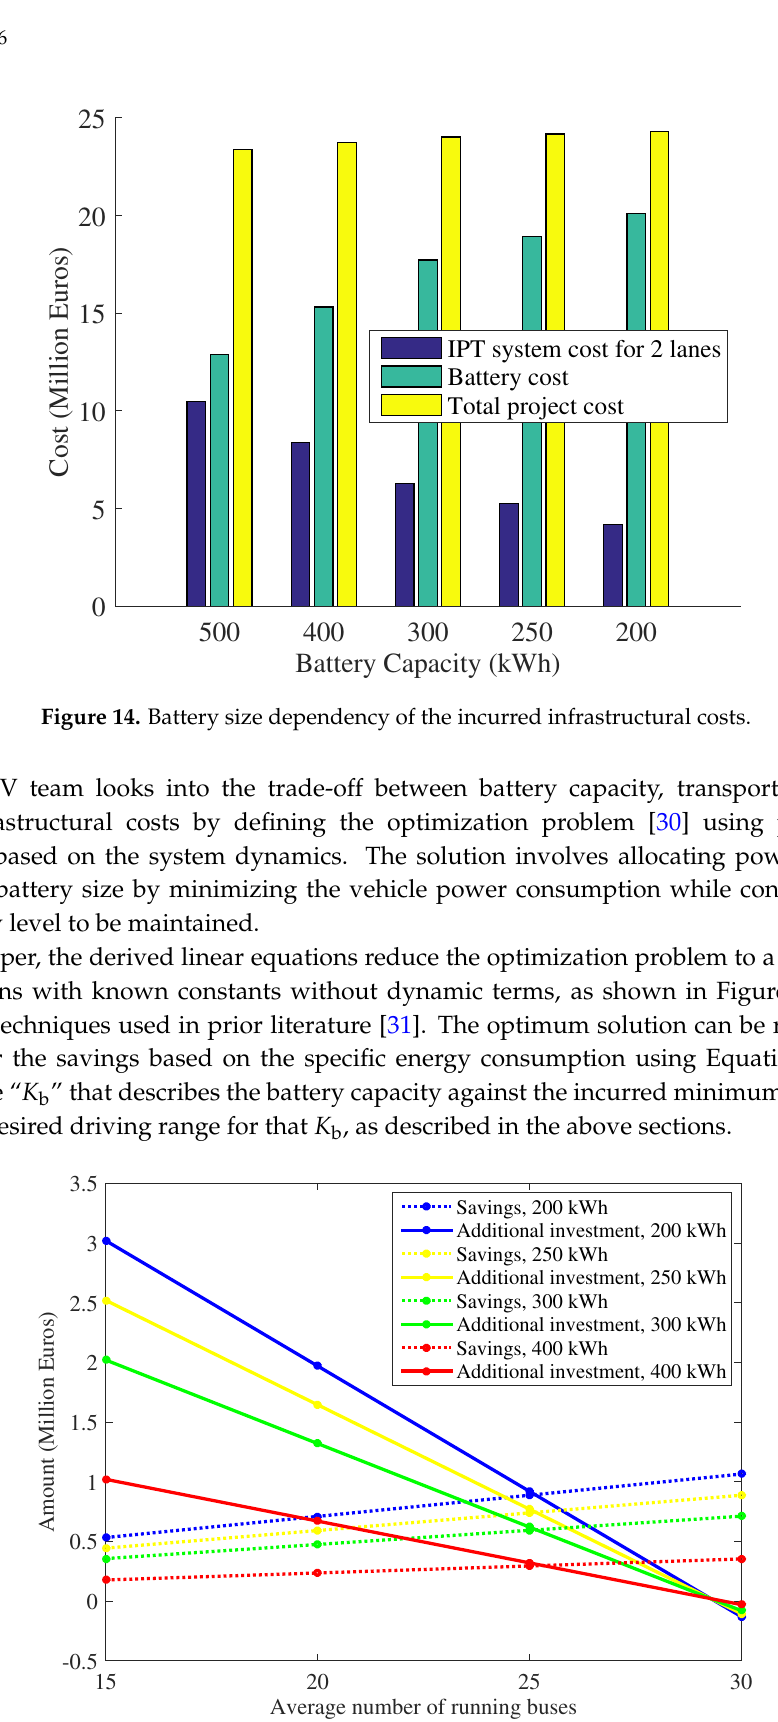
Figure 15. Savings and change in initial investment for different battery sizes with respect to a 500 kWh on-board battery